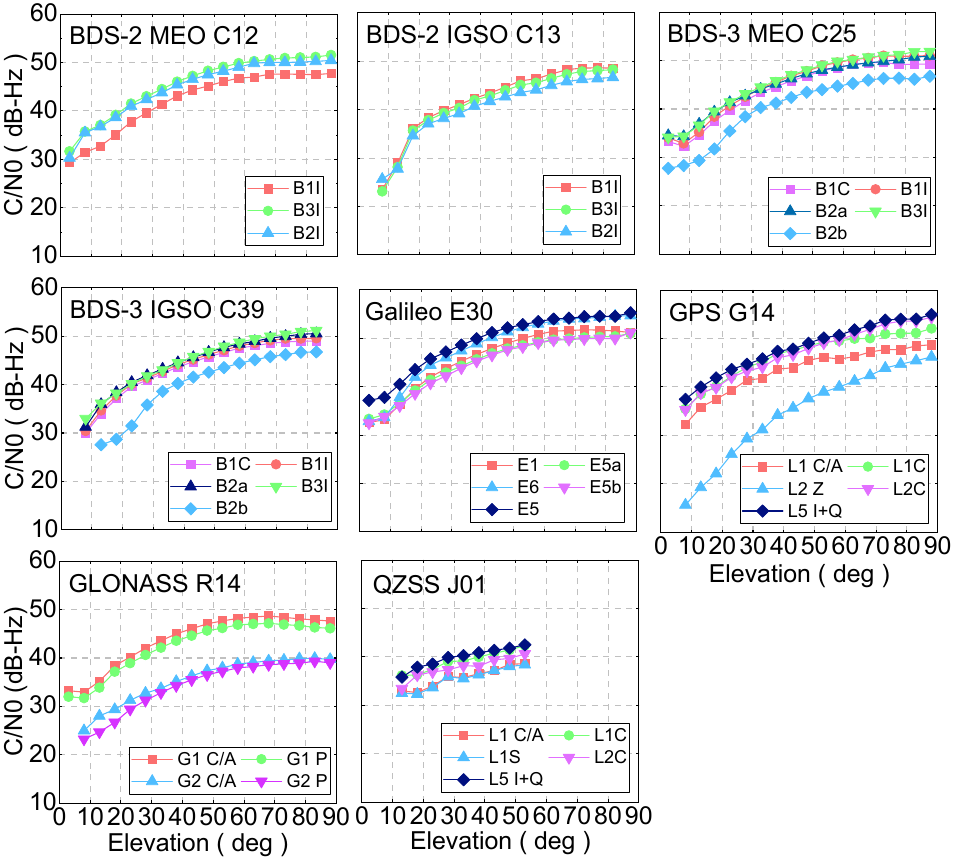
Figure 2. The average C/N0 versus elevation angle of BDS-2/ BDS-3/GPS/QZSS/GLONASS/Galileo from DOY 283 to 289, 2021.